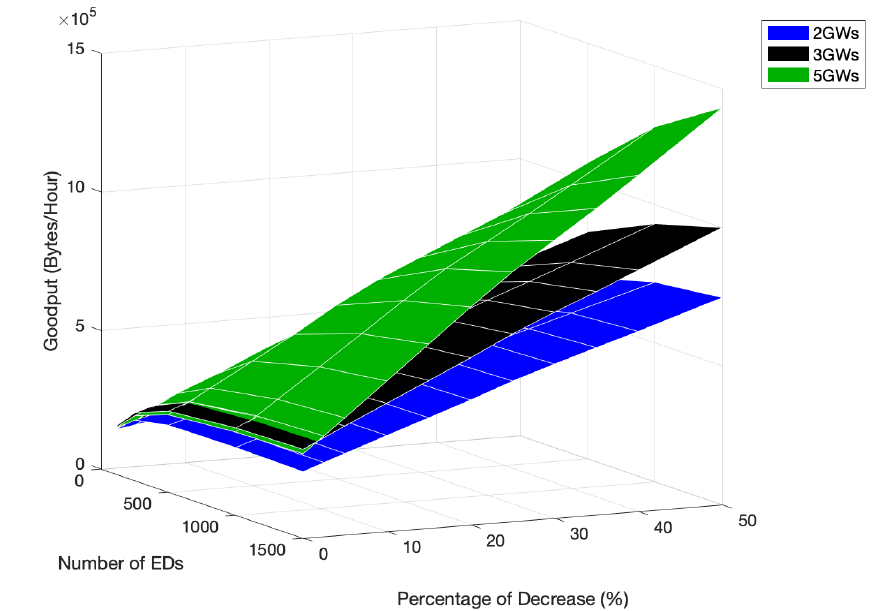
Figure 20. Network goodput comparison for different numbers of GWs, network sizes, and PoD.